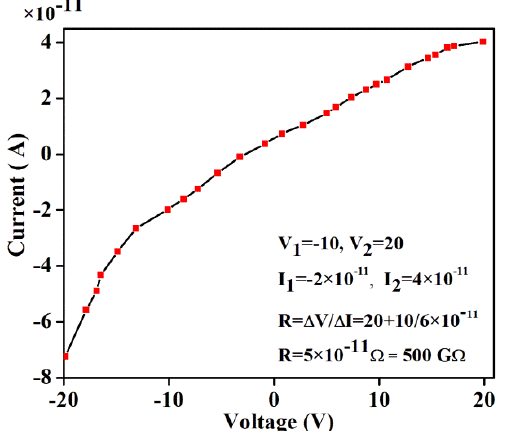
Figure 7. I-V curve of the junction between the two electrodes in the absence of DNA